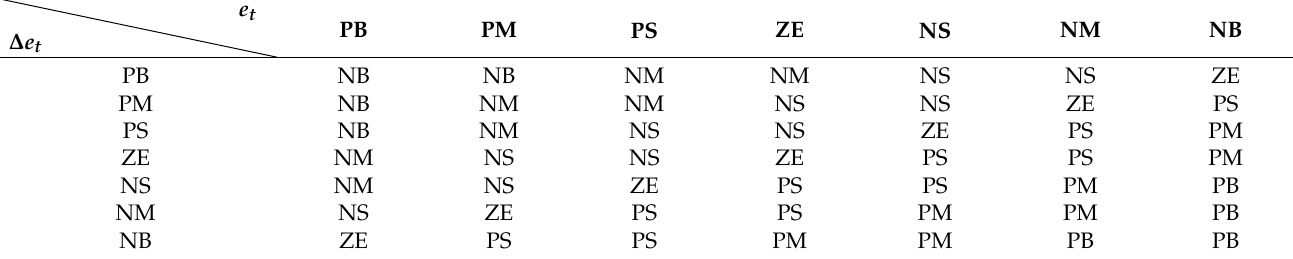
Table 5. Rules for the seven-stage fuzzy controller.